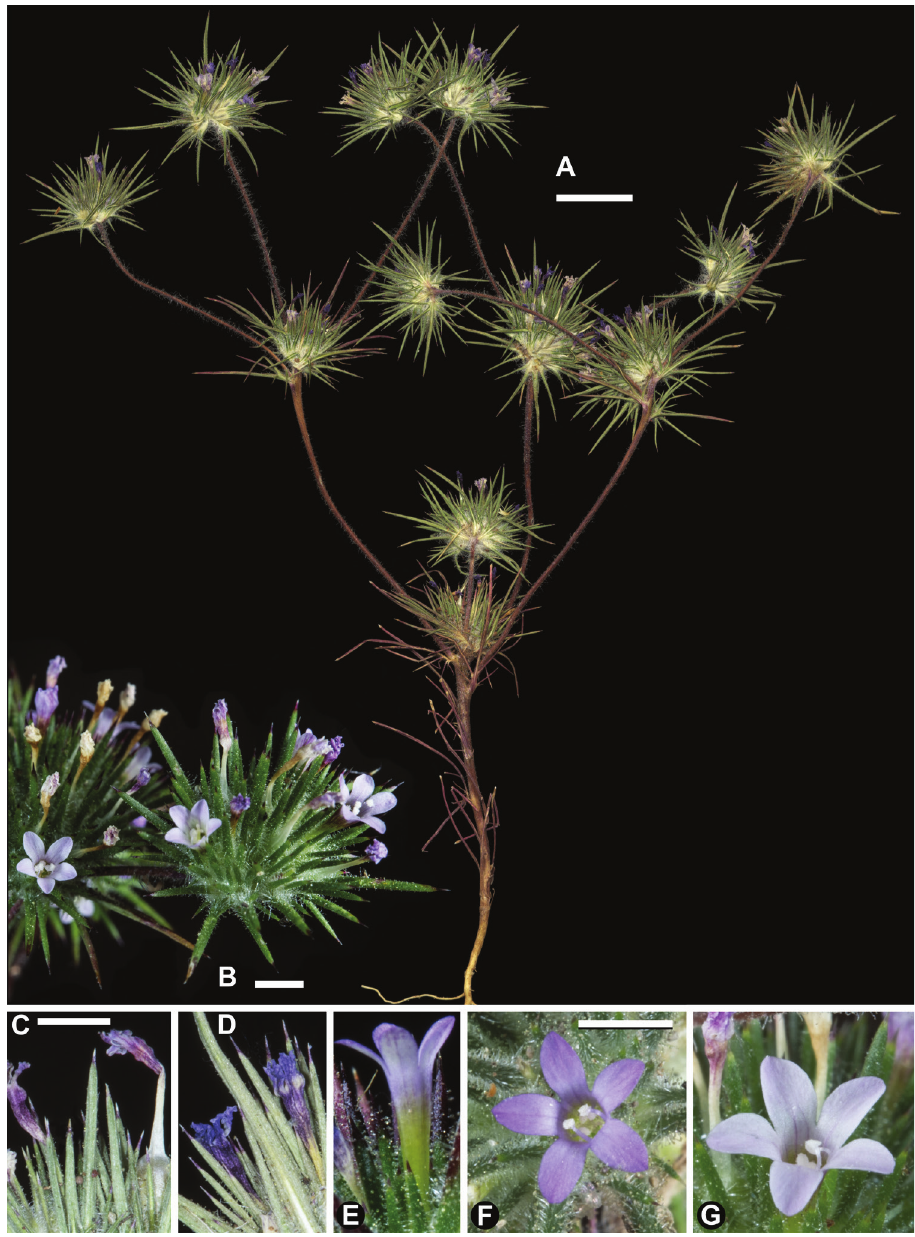
Figure 5. Navarretia modocensis . A Pressed specimen showing plant habit, scale bar = 1 cm ( Johnson 04-130 ) B Flowering head in the field, scale bar = 2 mm ( Johnson 16-072 ) C, D Pressed flowering heads showing range of typical coloration, equivalent magnification, scale bar = 2 mm ( Johnson 04-124, 04-130, respectively) E–G Fresh flowers showing typical coloration and white pollen, equivalent magnification, scale bar = 2 mm. ( E, F = Johnson 14-170; G = Johnson 16-0 72). All photographs by L. A. Johnson and vouchers deposited at